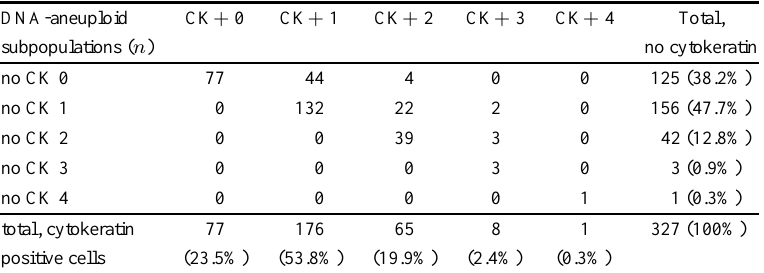
Breast cancer. Detection of DNA-aneuploid subpopulations dependent on gating of cytokeratin positive cells DNA-aneuploid